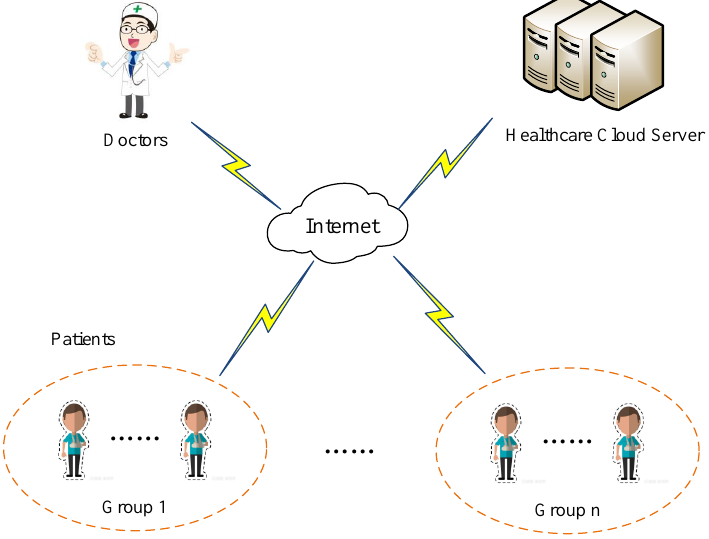
Figure 1. A typical G-PKEET application